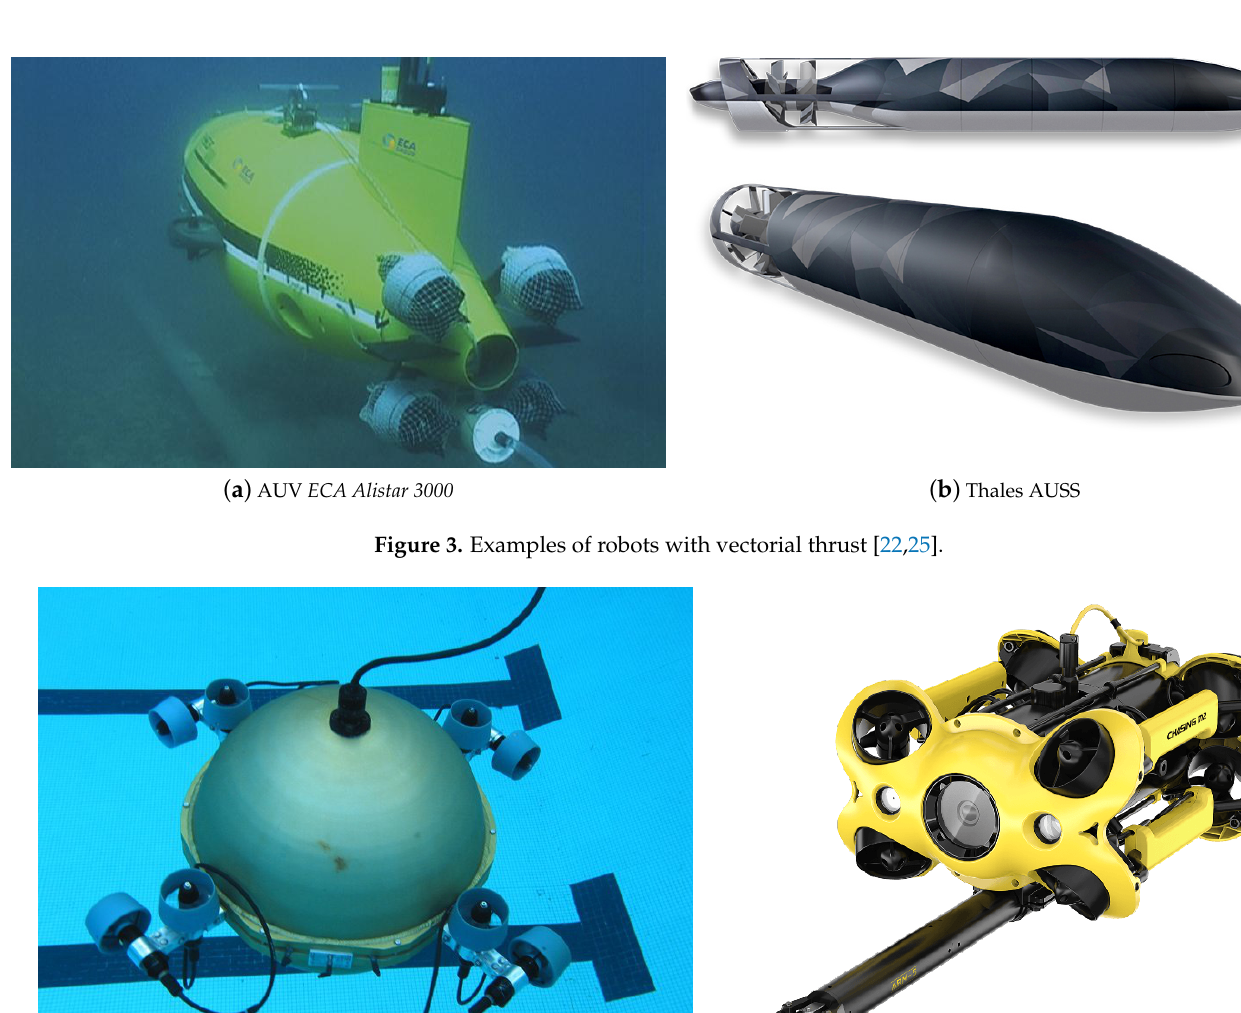
Figure 2. Examples of biomimetic and bioinspired underwater robots [16,17].